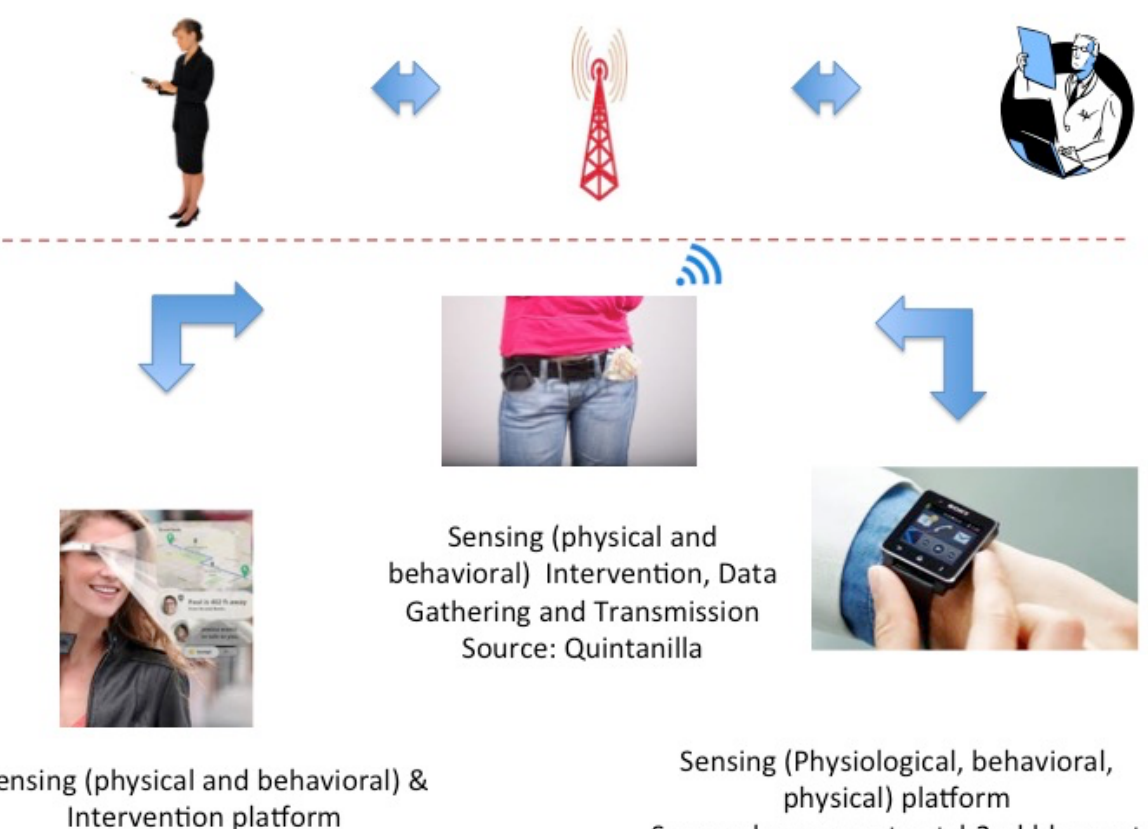
Figure 1 . WHealth